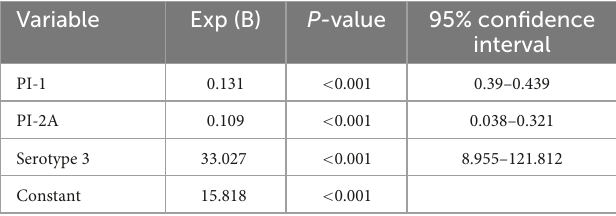
TABLE 7 Multivariate logistic regression analysis of predictors of early-onset disease